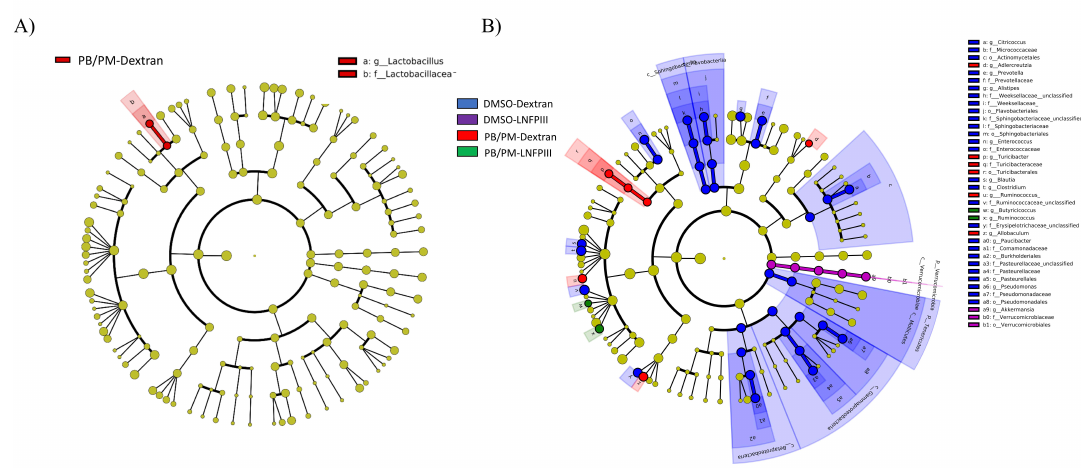
Figure 2. Linear discriminant analysis (LDA) effect size (LEfSe; Kruskall–Wallis ( p < 0.05); Pairwise Wilcoxon ( p < 0.05); logarithmic LDA score > 2.0) of the fecal microbiota of mice exposed to either DMSO-Dextran, DMSO-LNFPIII, PB / PM-Dextran, or PB / PM-LNFPIII. Greater sequence